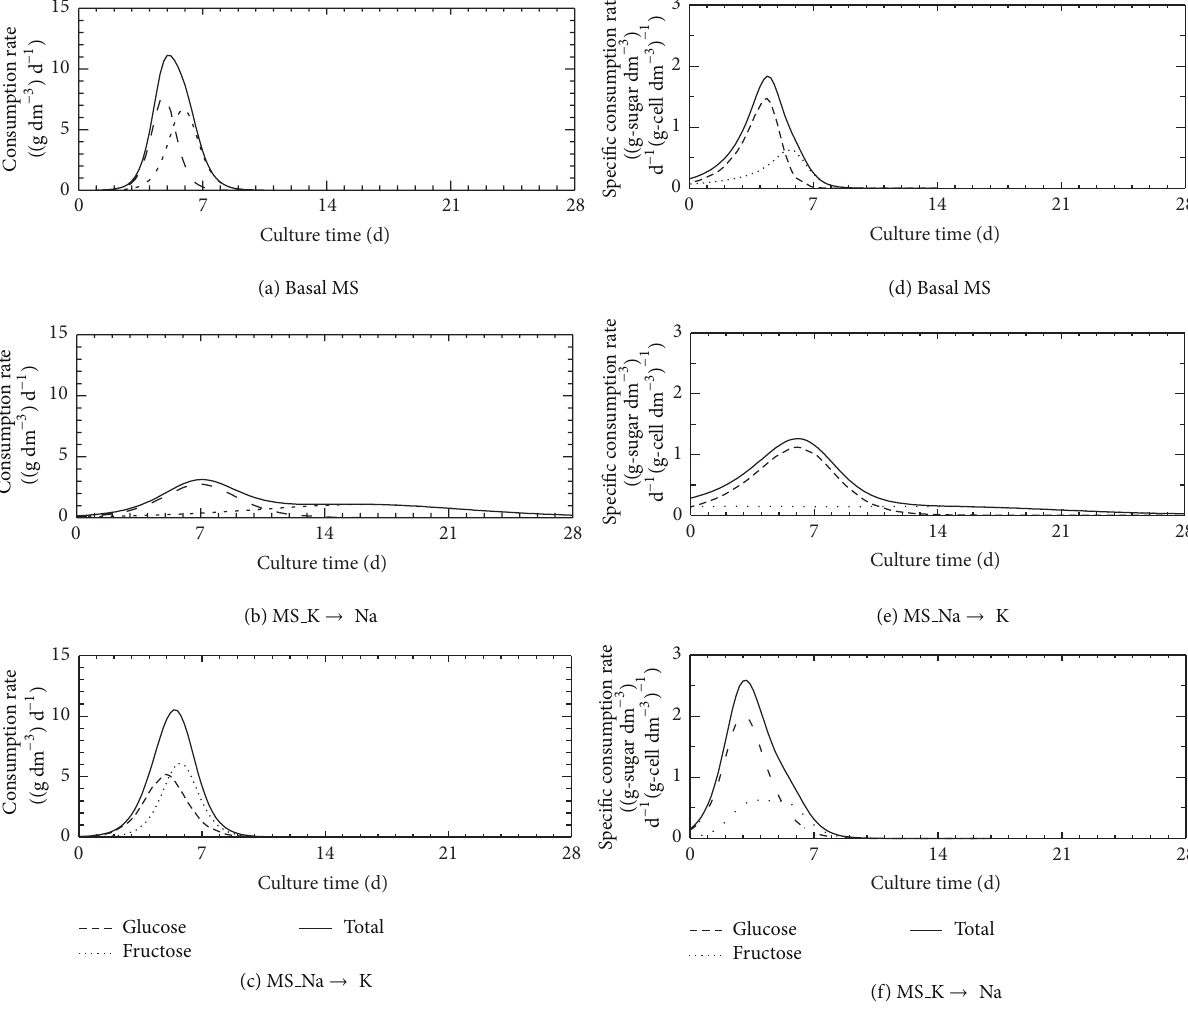
Figure 5: Time courses of consumption and specific consumption rates of glucose, fructose, and total sugar in cultivations using basal MS ((a), (d)), MS K → Na ((b), (e)), and MS Na → K ((c), (f))